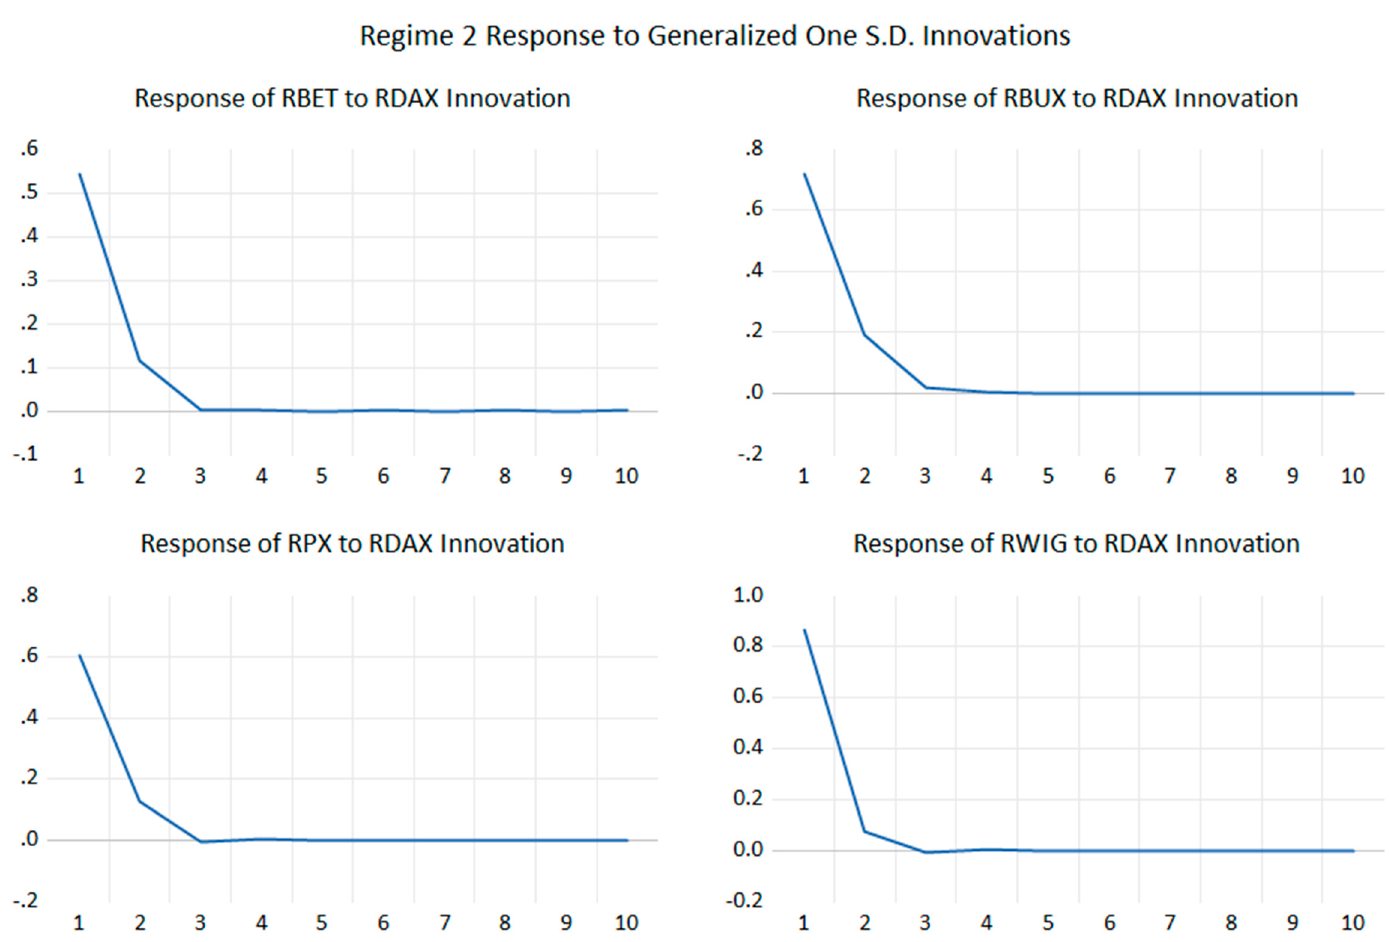
Figure A10. Impulse Responses of CEE Stock Markets to a Shock in the German Stock Markets in Both Regimes.